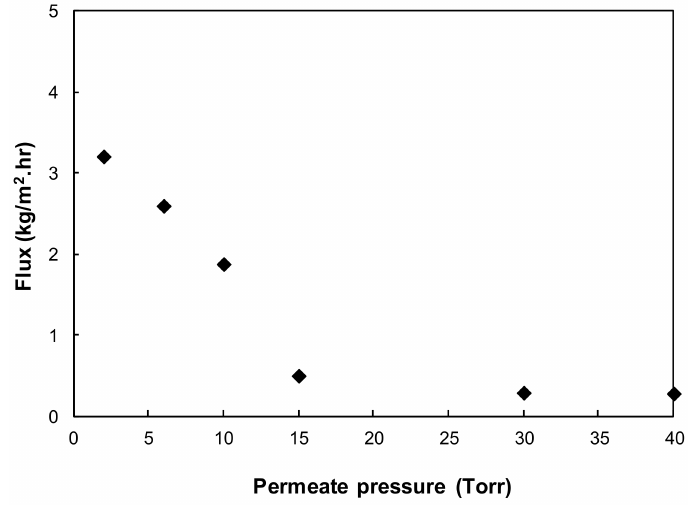
Figure 4. Effect of vacuum on water flux (membrane thickness 20 µ m, feed temperature 21 ◦ C, feed velocity 0.05